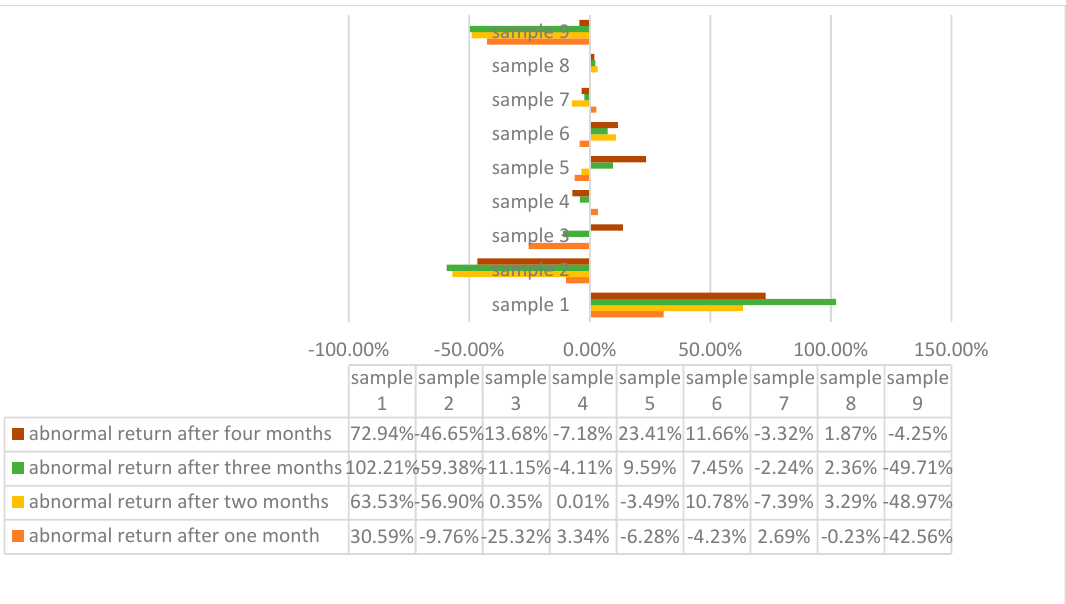
Figure 10 . Change in the stock price four months before and after the split date.